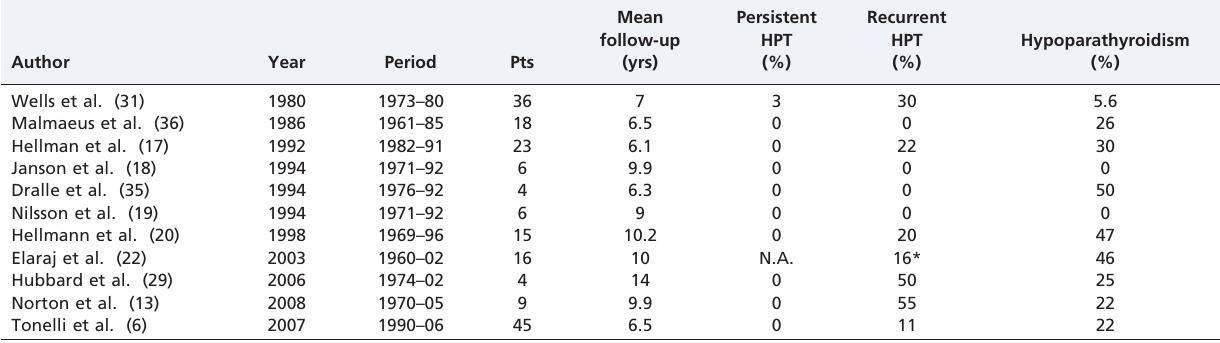
Table 2 - Results after total parathyroidectomy (TPTX) in multiple endocrine neoplasia type 1 (MEN1)- hyperparathyroidism (HPT).